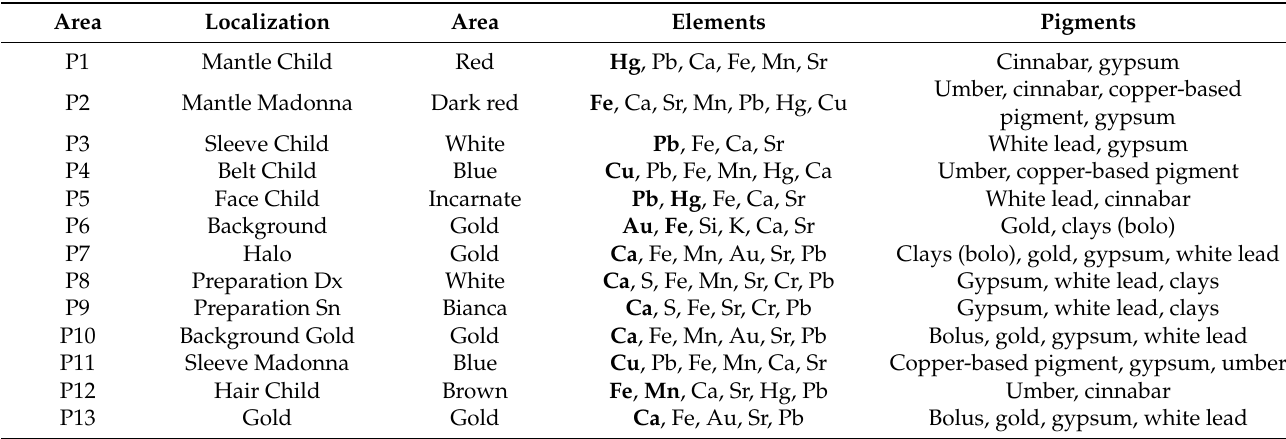
Table 1. Areas analyzed by XRF spectroscopy, localization, color, identified elements, and corresponding estimated pigments. Majority elements are shown in